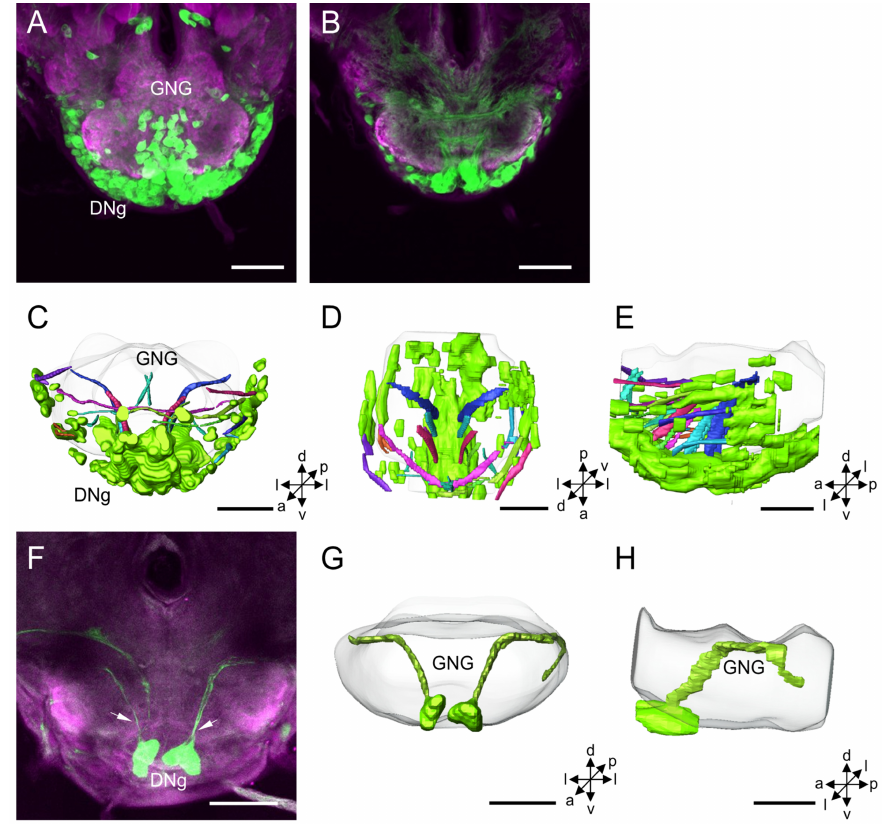
Figure 7. Distribution and projection patterns of DNg neurons in the brain: ( A , B ) projection views of confocal stack images showing DNg somata and primary neurites; ( C – E ) the anterior, dorsal, and lateral views of the three ‐ dimensional reconstruction showing DNg somata and primary neurites; ( F ) projection views of confocal stack images showing somata in the medial of DNg cluster and their primary neurites (arrows); and ( G , H ) the anterior and lateral views of the three ‐ dimensional recon ‐ struction of cells with somata in the medial of DNg cluster and their primary neurites in the brain. GNG, gnathal ganglion. a, anterior; d, dorsal; l, lateral; p, posterior; v, ventral. Scale bars: 100 μ m.